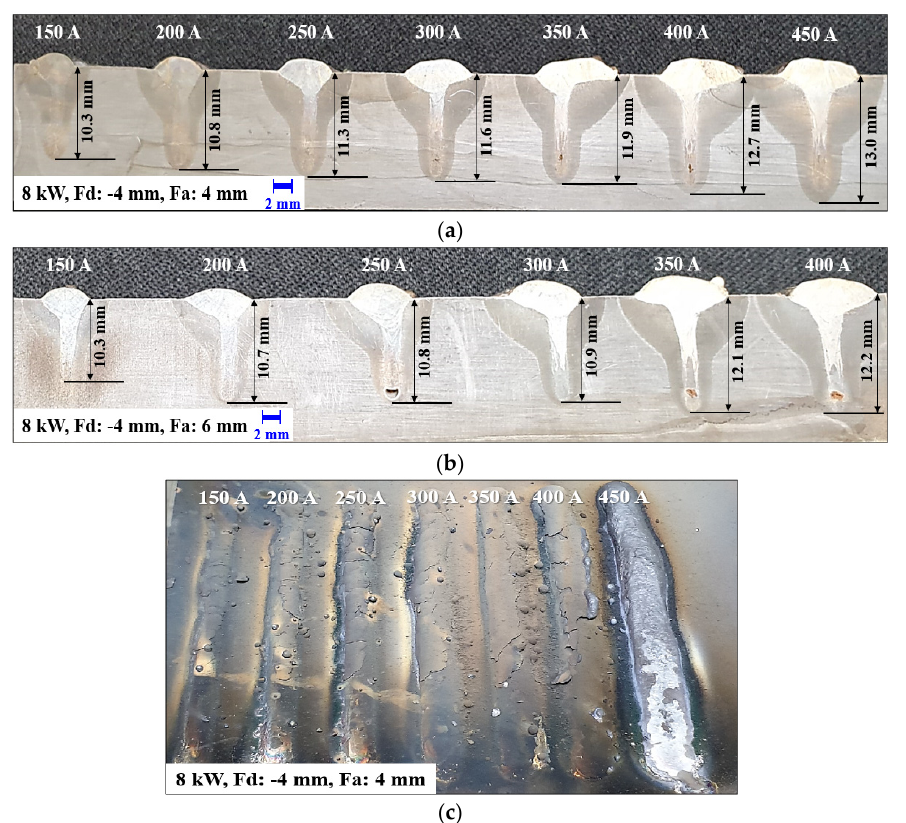
Figure 4. Penetration depth and weld face spatter aspects observed during laser-MIG hybrid welding conditions of high-Mn steel. ( a ) Macro cross section of the specimen for a power output of 8 kW, Fd = − 4 mm, and Fa = 4 mm; ( b ) macro cross section of the specimen for a power output of 8 kW, Fd = − 4 mm, and Fa = 6 mm; ( c ) weld face spatter aspect after the BOP